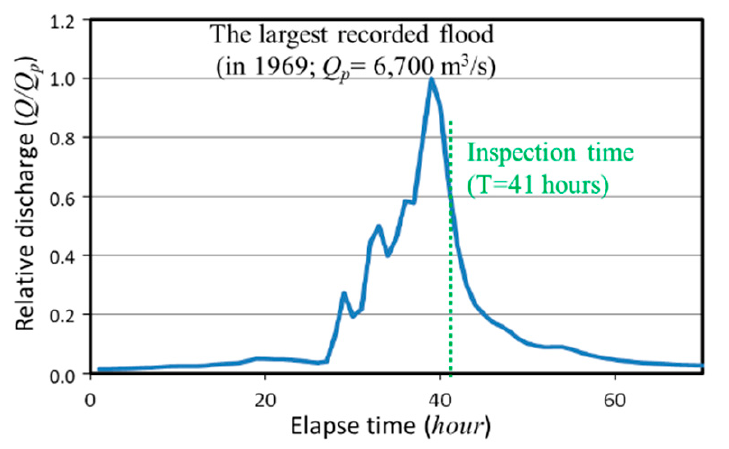
Figure 10. Normalized flood hydrograph.